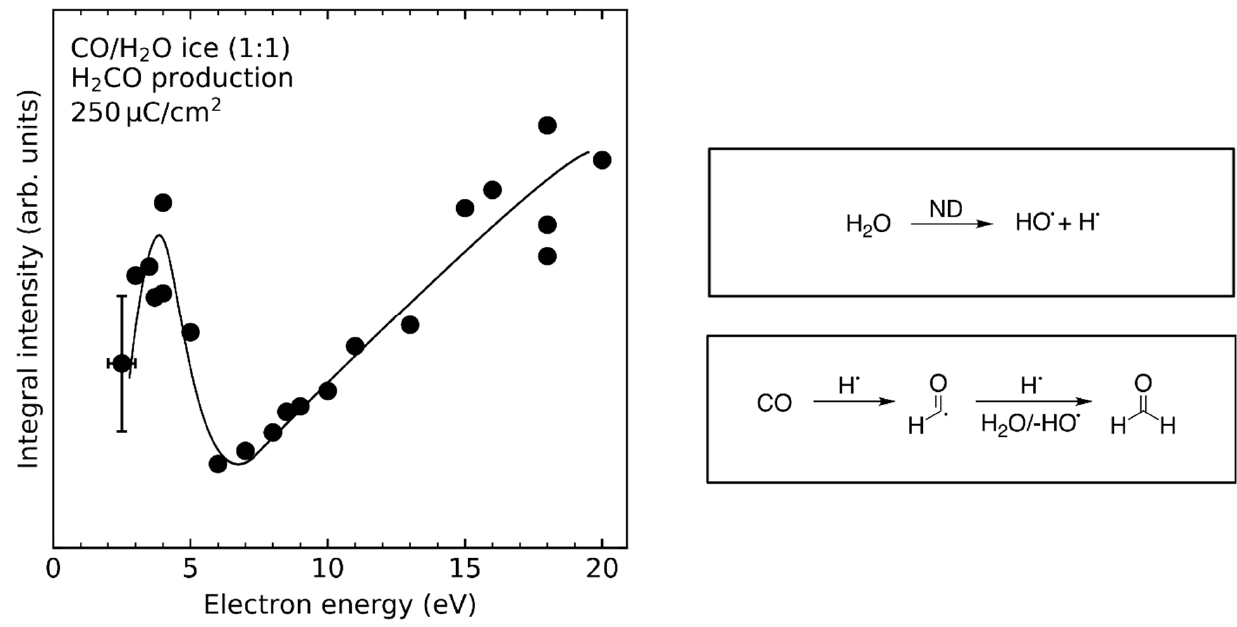
Figure 10. ( Left panel) Dependence of the integrated desorption signal of H 2 CO on electron energy obtained by TDS after irradiation of CO/H 2 O (1:1) mixed ices with 250 µ C/cm 2 . Note that the data points below 10 eV are identical to those in Figure 9. ( Right panel) Reactions leading to the formation of H 2 CO by ND of H 2 O. The solid line serves as a guide to the eye. Adapted with permission from Ref. [24]. Copyright 2019 American Chemical Society.